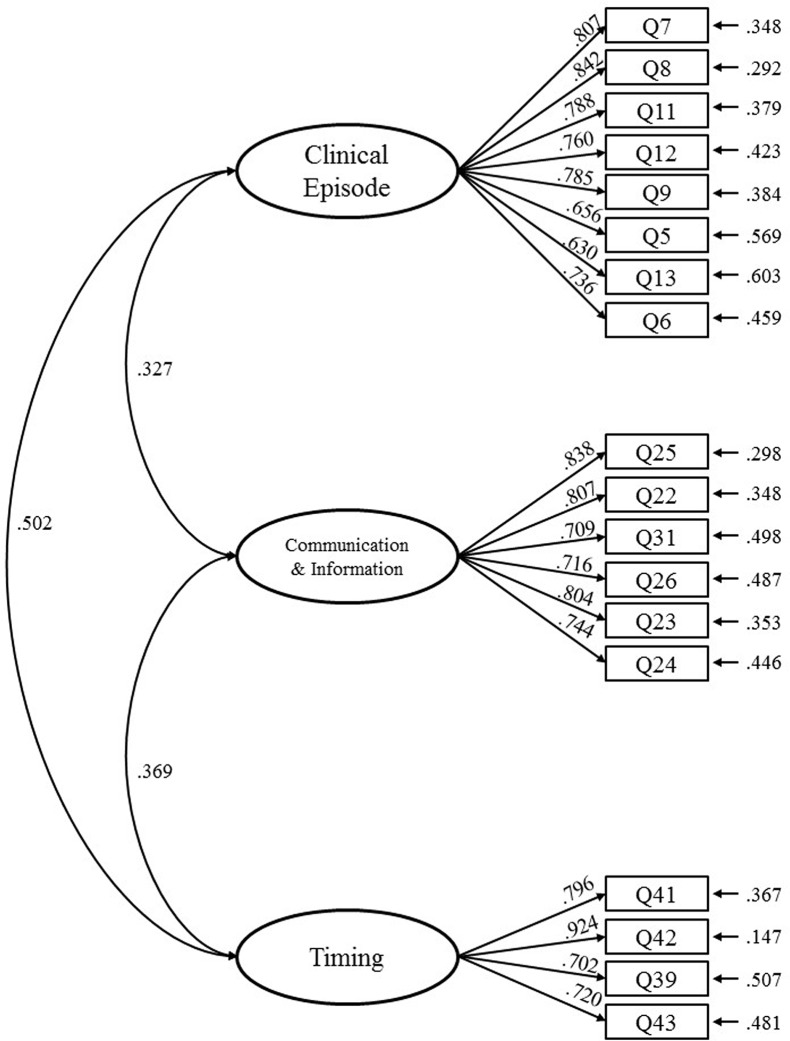
The PTDDS measurement model of confirmatory factor analysis.